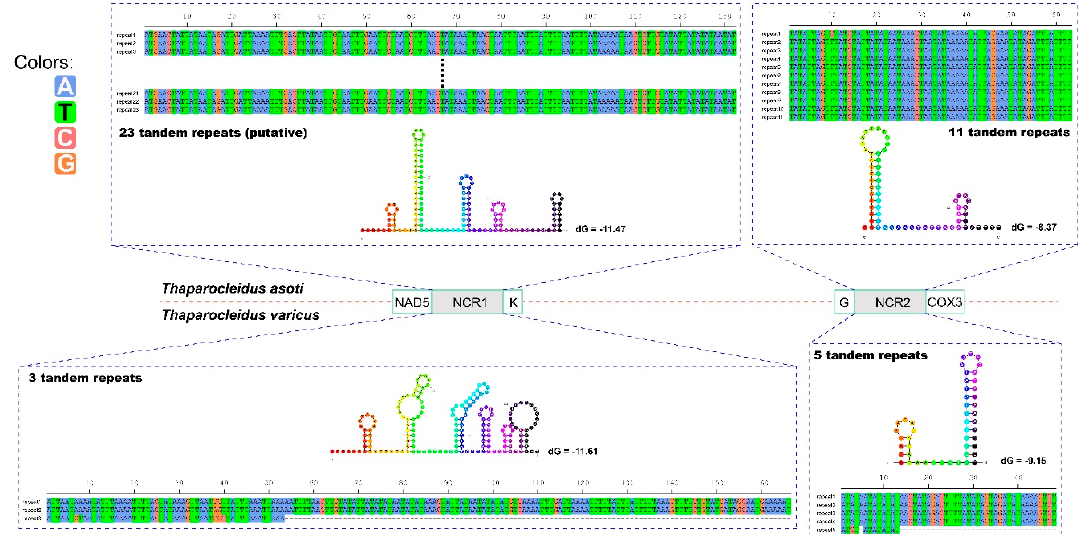
Figure 2. Stem-loop structures of the consensus repeat patterns in repetitive regions of the non-coding regions of Thaparocleidus asoti and Thaparocleidus varicus . Thermodynamic energy values (dG) are shown next to the secondary structures. The nucleotide A is blue, T is green, C is deep pink and D is